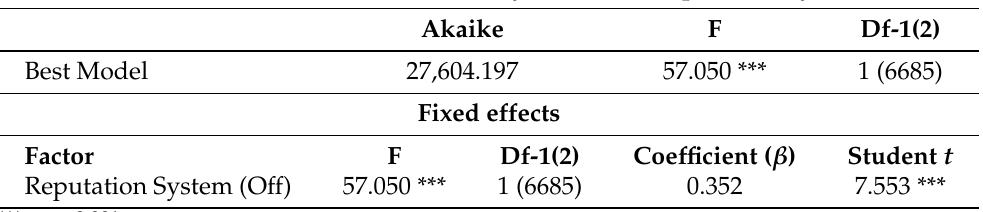
Table 6. Generalized Linear Mixed Models 3. Effect of the introduction of a reputation system on the